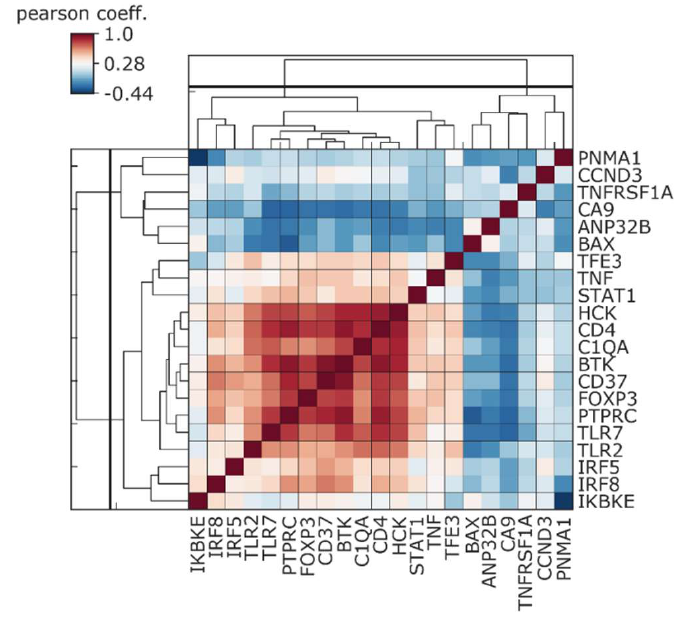
Figure 9. Negative correlation between CA9 and immune panel genes which are upregulated in samples with better prognosis. The analysis was performed with a cohort of 183 PDAC samples from TCGA (Xena).